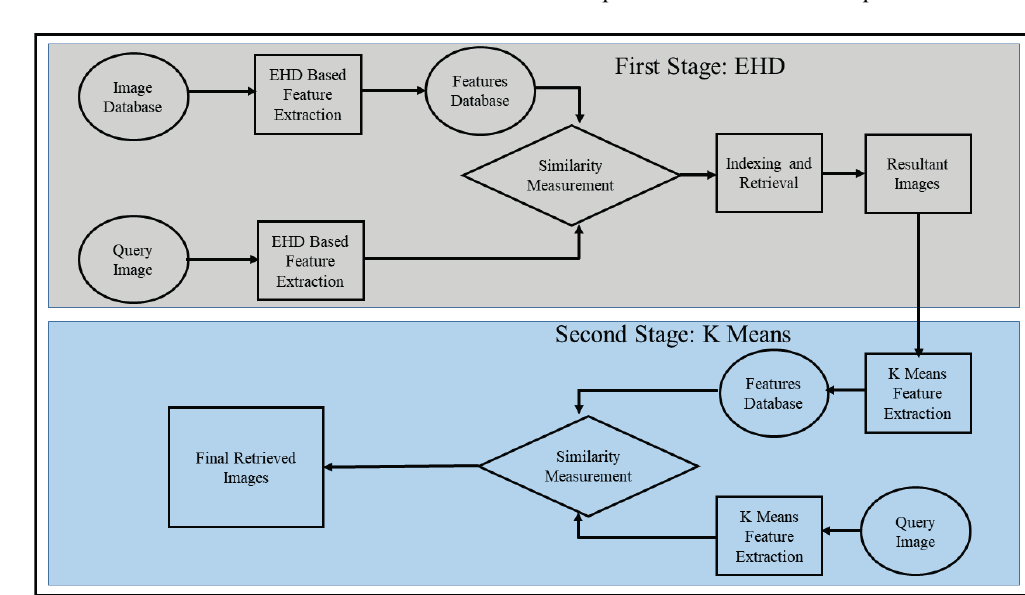
Fig. 4. EHD and K-Means based CBIR.